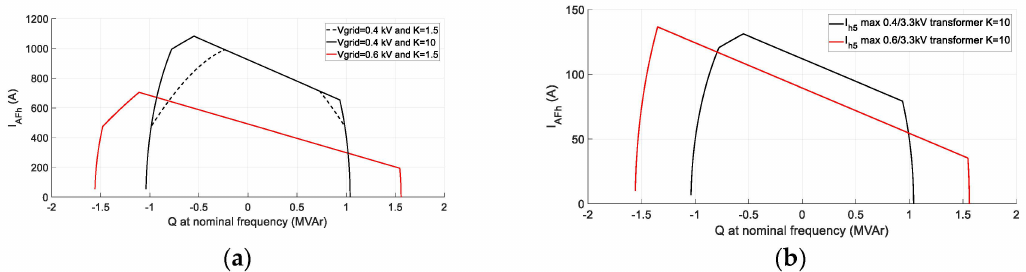
Figure 12. Maximum 5th order current limit at nominal voltage for a 400 V and 600 V nominal grid voltage: ( a ) current at the LV side of the transformer and ( b ) current at the MV side of the